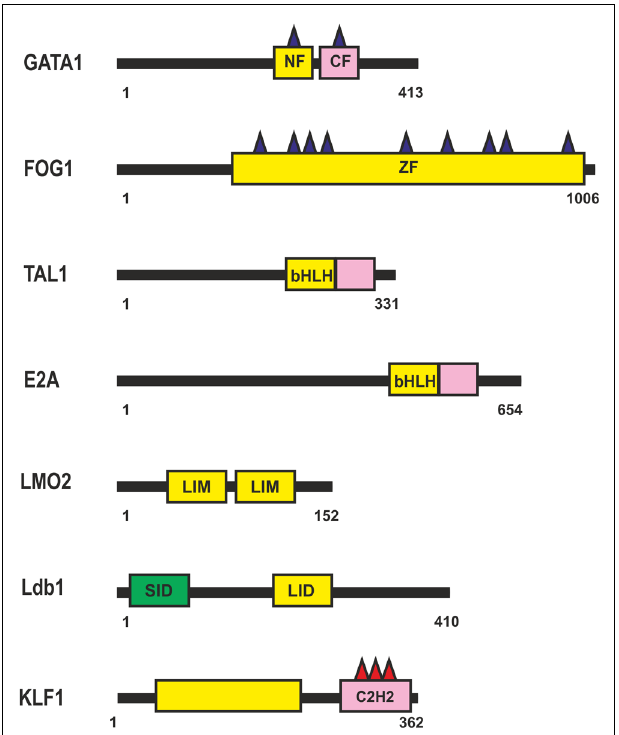
FIGURE 4 |Transcription factors involved in regulation of the β -globin locus during erythropoiesis. N-termini C4-type zinc finger domain (NF), C-termini C4-type zinc finger domain (CF), CCHC-type Zinc-Finger domain (ZF), Basic Helix-Loop-Helix domain (bHLH), Lin11, Isl-1, and Mec-3 domain (LIM). For other designations, see Figure 1